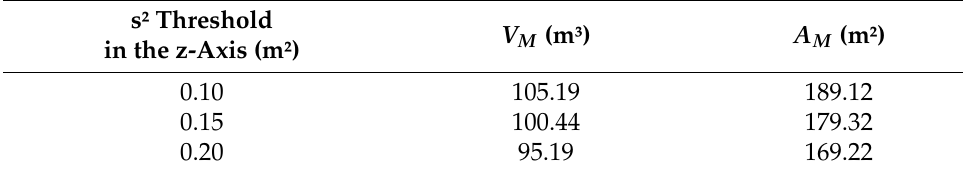
Table 4. Results of the canopy measurements: for each of the applied variance thresholds, the canopy volume and occupancy area are